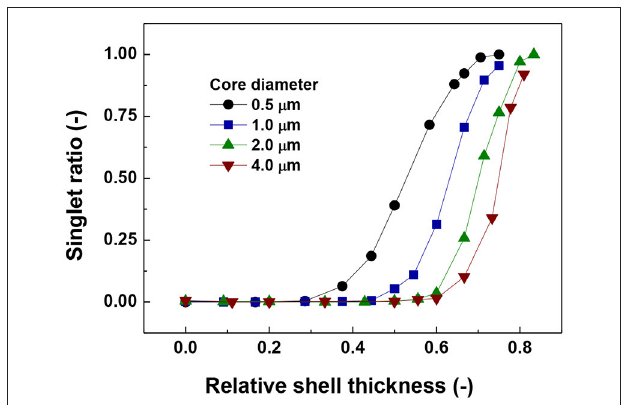
FIGURE 2 | Ratio of number of singlets to the total number of particles vs. relative shell